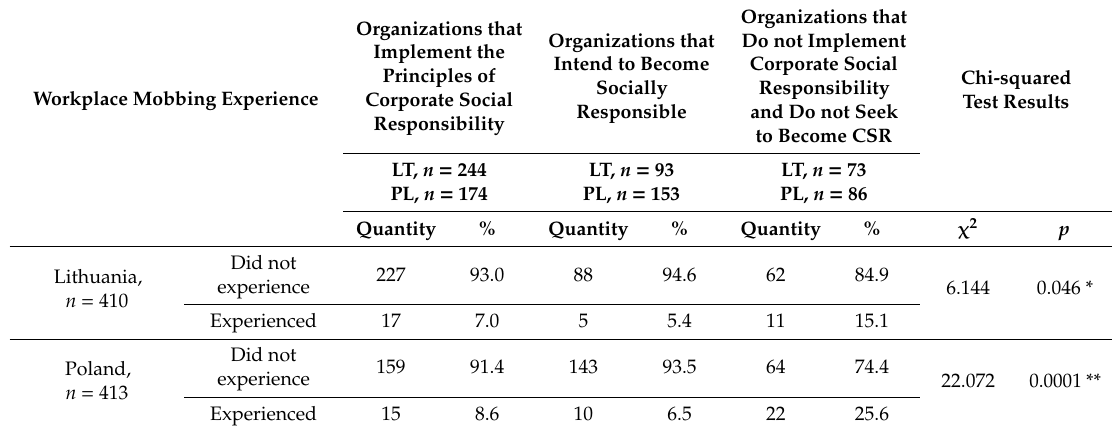
Table 4. Workplace mobbing experience in Lithuanian and Polish organizations.